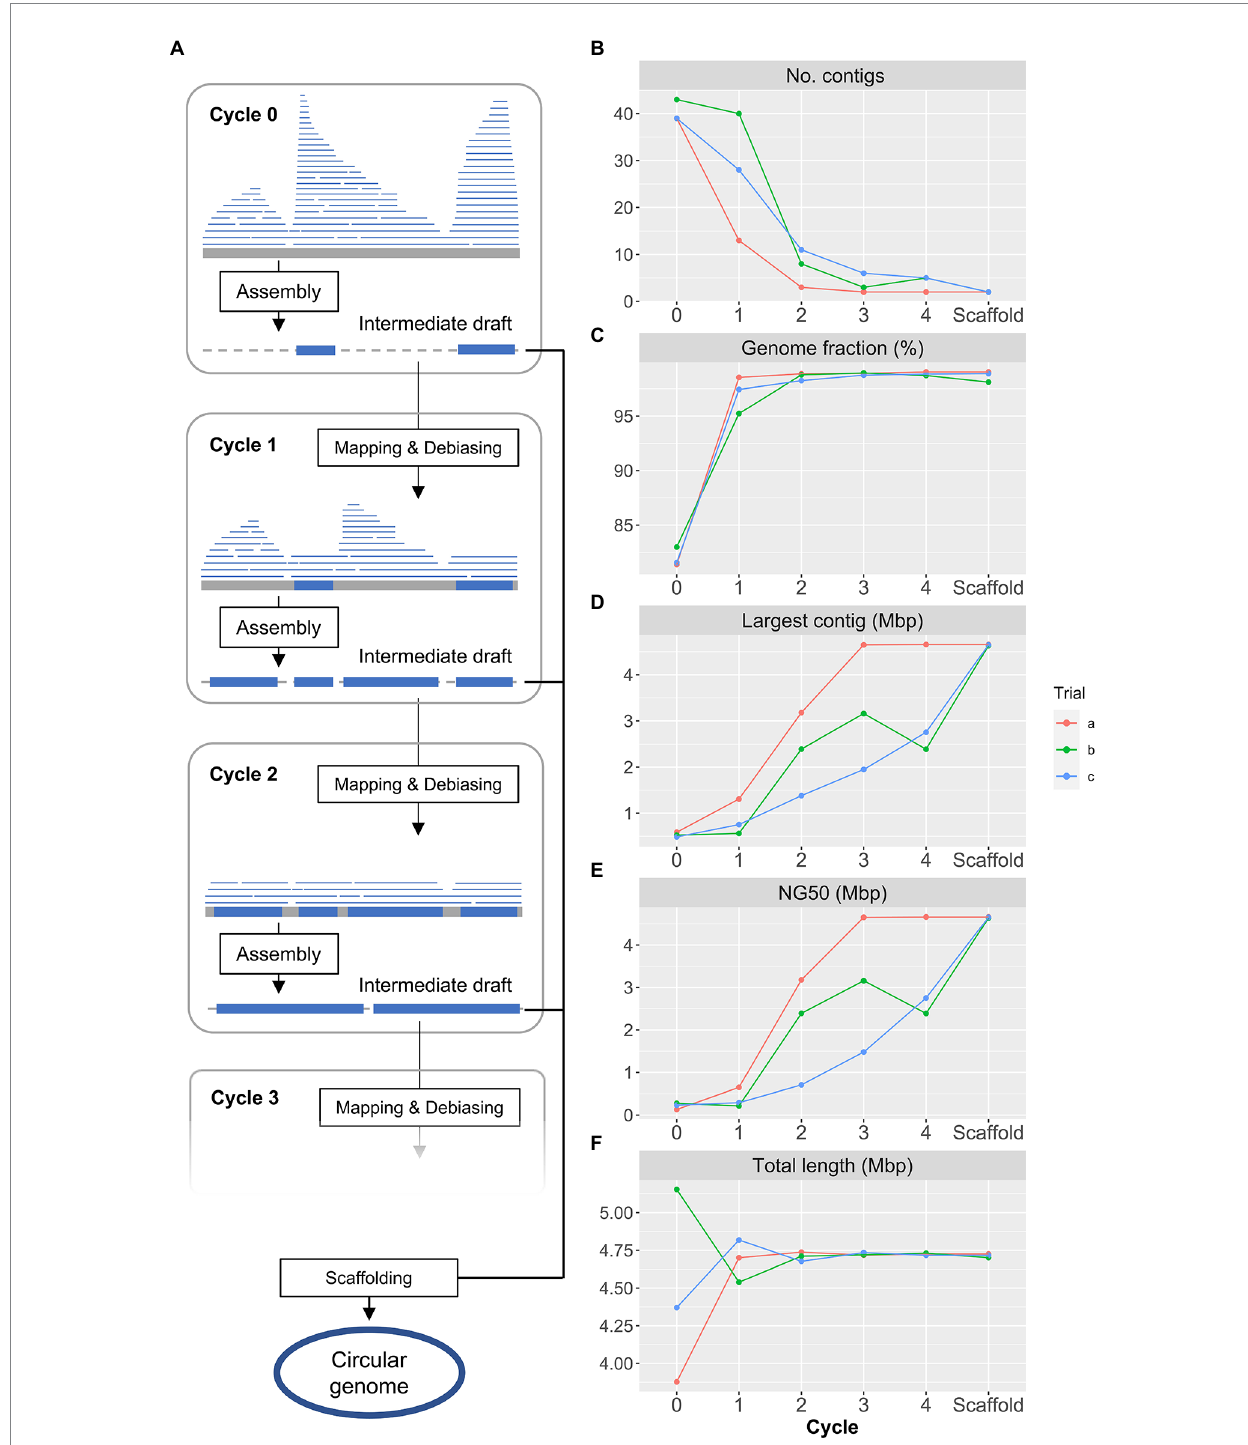
FIGURE 1 Workflow of single-amplified genome long-read assembly (scALA) pipeline to obtain circular bacterial genomes. (A) The assembly of original single- cell long-read sequences (scLRs) obtained from SAGs produces a low-completeness draft genome (LR-SAG) owing to biased sequence depth caused by uneven genome amplification (Cycle 0). To improve the quality of LR-SAG, the assembly of debiased long reads is repeated by read mapping to the pre-assembled intermediate draft LR-SAG (Cycle 1, Cycle 2, …). Finally, circular LR-SAG (cSAG) is obtained by scaffolding multiple intermediate draft LR-SAGs in each cycle. (B–F) Quality of LR-SAGs in scALA process ( B : number of contigs, C : genome fraction, D : length of the largest contig, E : NG50, F : total length). The line plot color indicates each scALA analysis trial using the same E. coli scLR